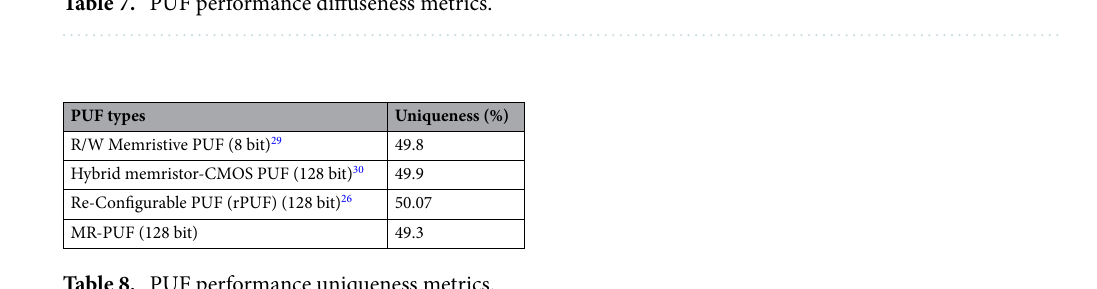
Table 8. PUF performance uniqueness